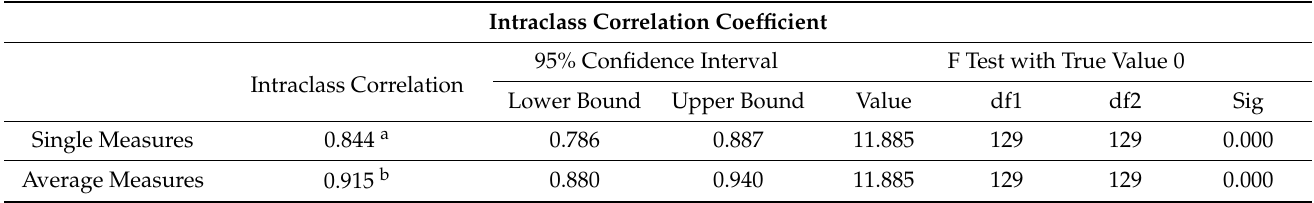
The two-way mixed-effects model where people effects are random and measures effects are fixed. a The estimator is the same, whether the interaction effect is present or not. b Type A intraclass correlation coefficients using an absolute agreement definition.